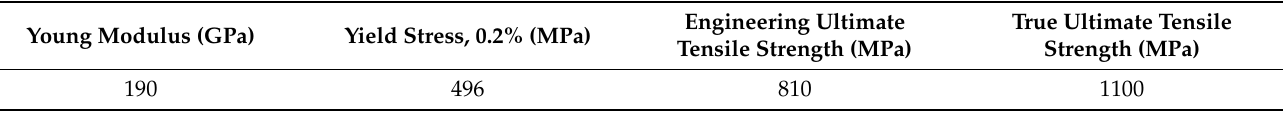
Table 2. Tensile properties measure for the MAMed Inconel 625.